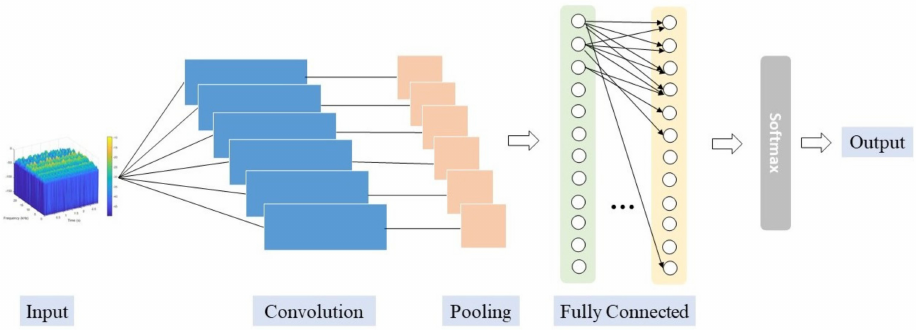
Figure 1. Framework of a convolutional neural network